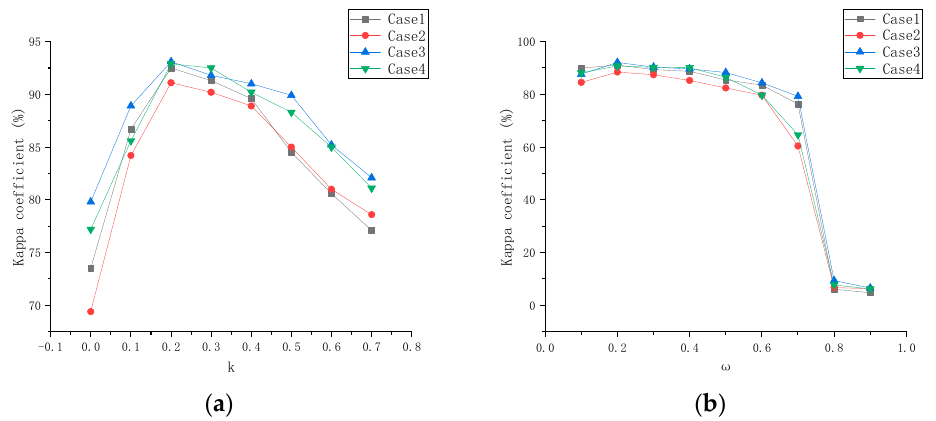
Figure 9. Sensitivity analysis of the proposed method to the parameters including ( a ) k ; ( b ) ω .